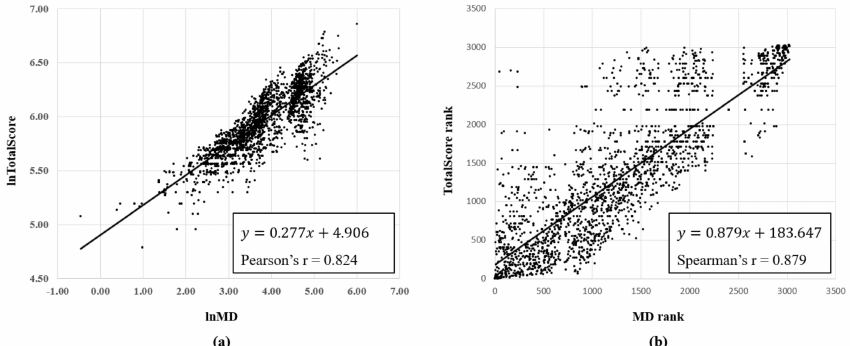
Figure 2. Results of correlation analysis between Mahalanobis distance (MD) and total score using Globally Harmonized System (GHS) categories: ( a ) Pearson correlation analysis and ( b ) Spearman rank correlation